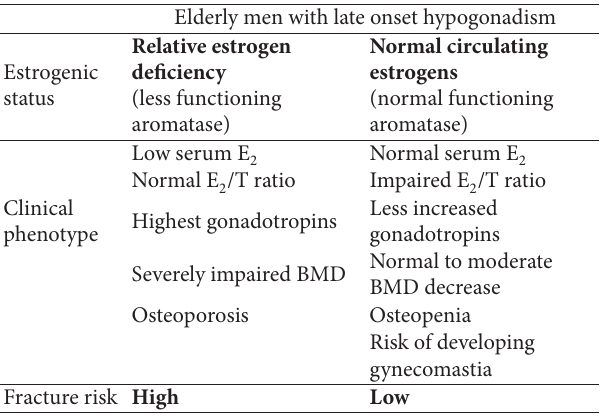
Table 2: Risk of osteoporosis and fractures along with clinical manifestations according to estrogen status in elderly